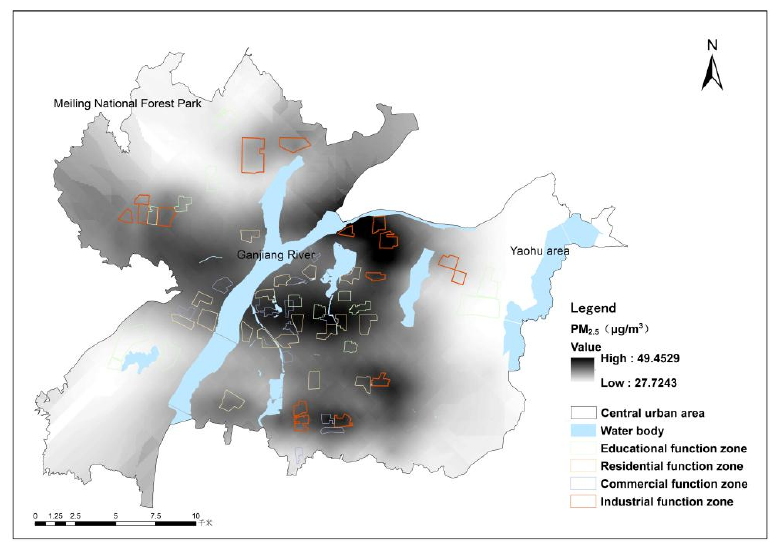
Figure 2. Spatial distribution of PM 2.5 concentration.